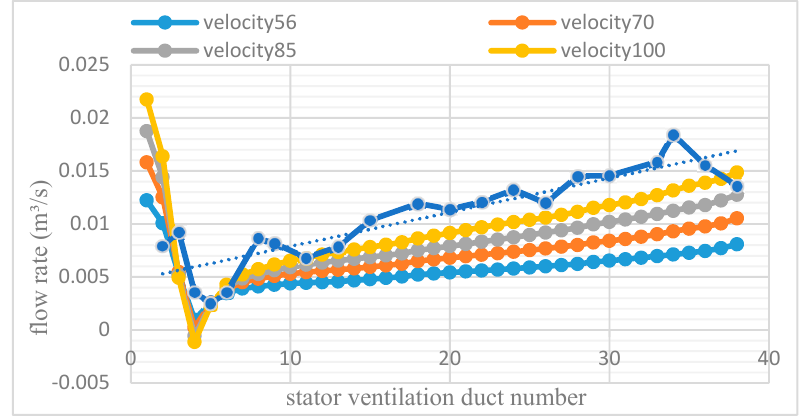
Figure 10. Flow rate distribution in the radial ventilation ducts at different air gap entrance velocities.